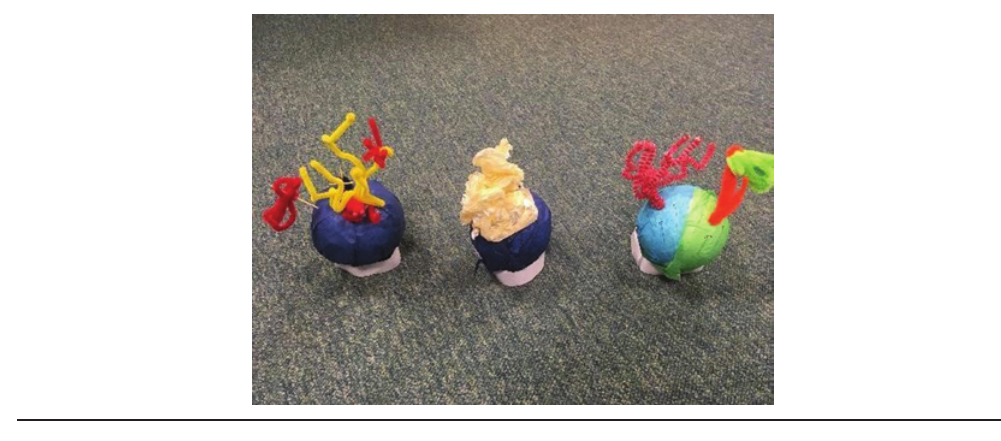
figure 3: a visual representation of research through three different lenses (photo: laurence De clippele)